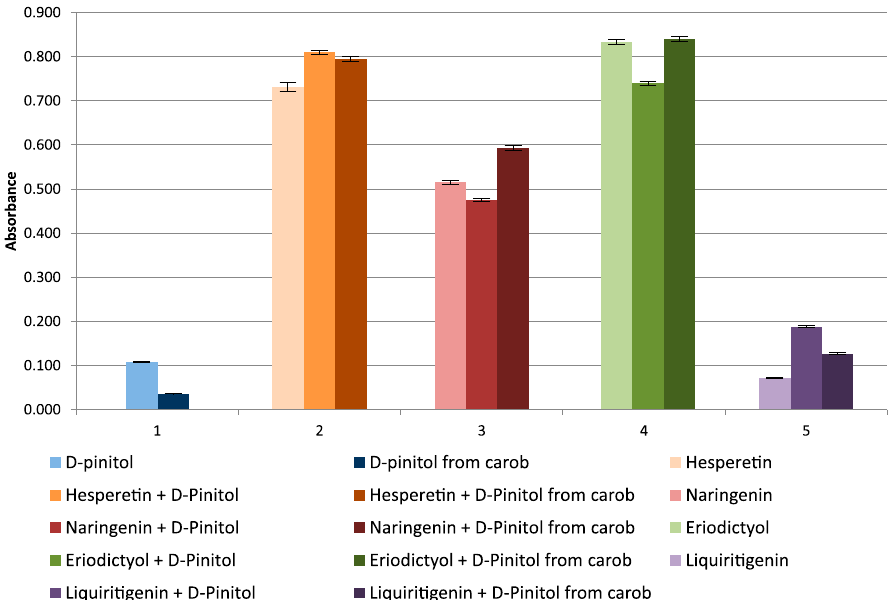
Figure 1. Absorbance change graph of D -pinitol (standard), D -pinitol from carob, flavanones and their mixtures with cyclitols.